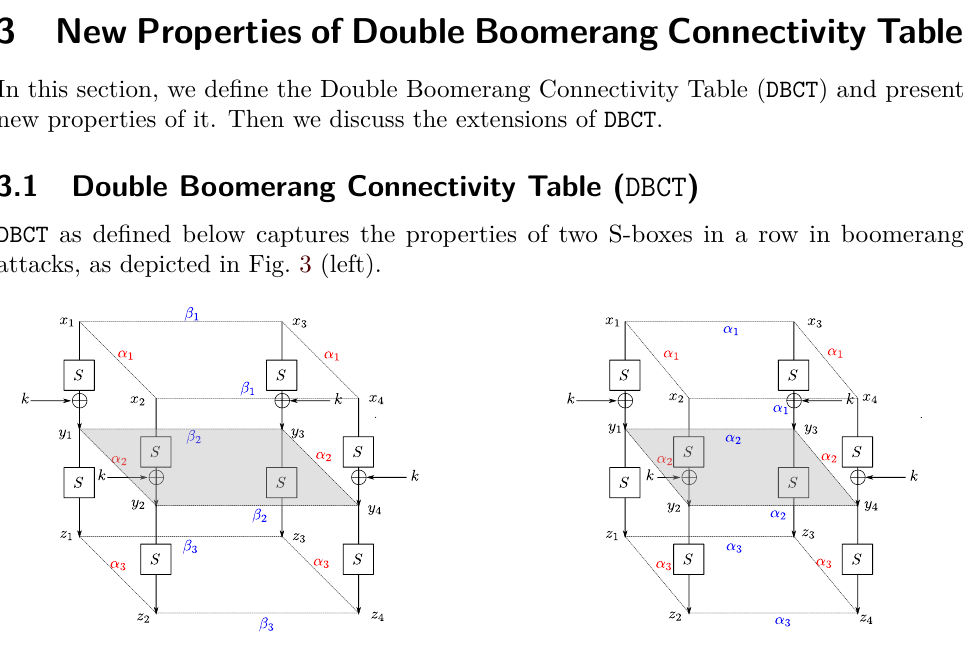
Figure 3: DBCT of general S-box (left) and DBCT of hard S-box in the sense of Definition 8